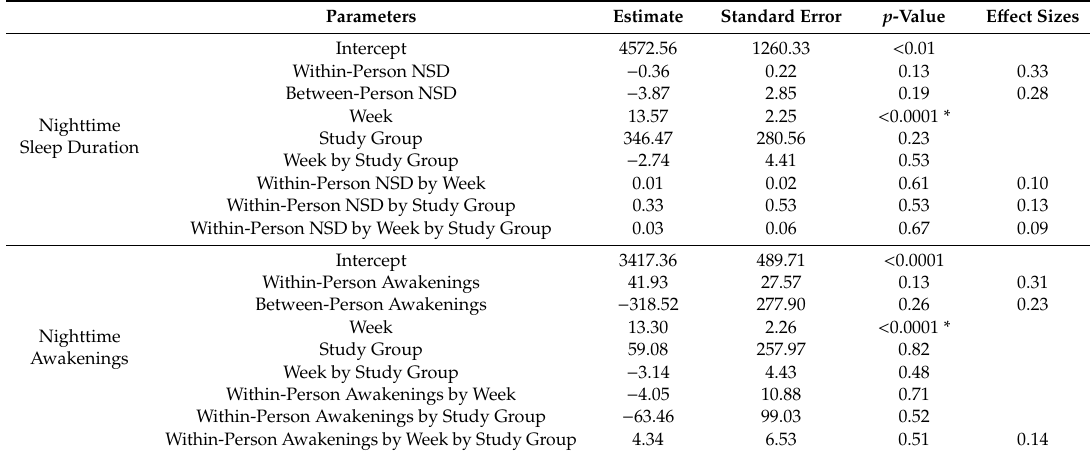
Table 3. Coe ffi cients for the Multilevel Models of Nighttime Sleep Duration and Nighttime Awakenings Predicting Weekly Energy Intake.